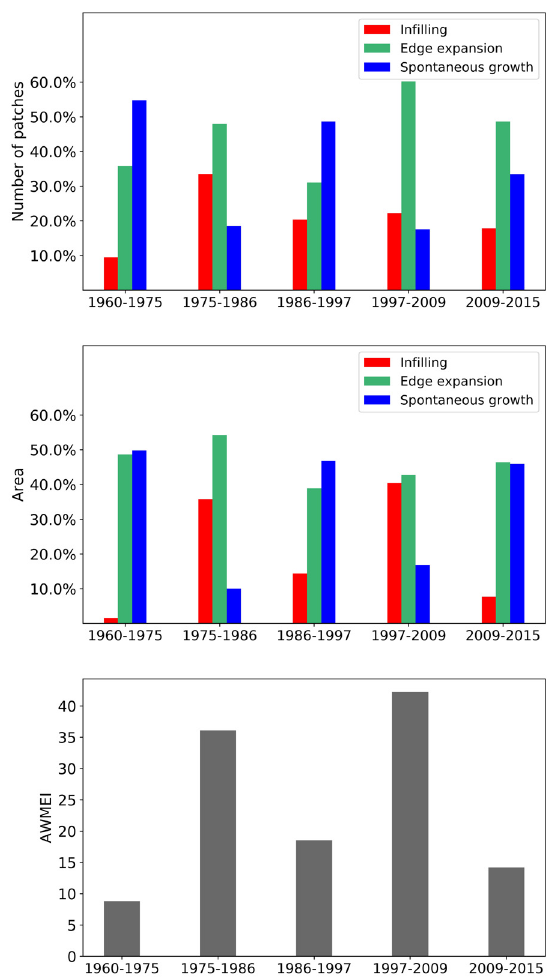
Figure 7. Temporal dynamics of urban expansion types and AWMEI values in the FDB from 1960 to 2015.